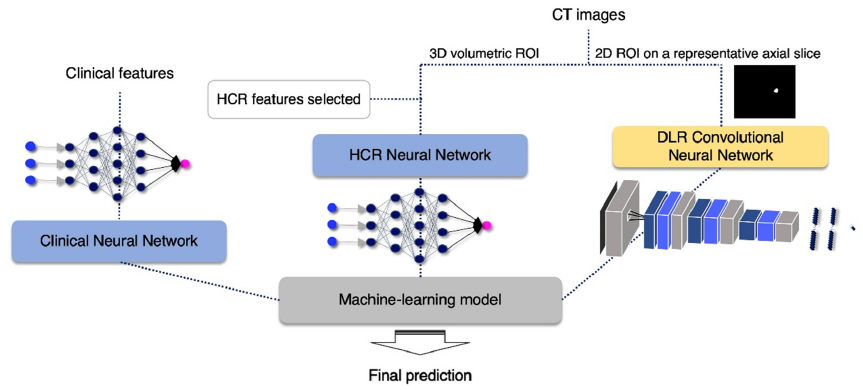
Figure 3. DLR convolutional neural network architecture . In the end, a machine learning-based analyzer was employed to combine the predic- tive outputs (cancer recurrence probability [0, 1]) of each neural network-based model to improve the accuracy of prior models (i.e., ensemble learning). The combined outputs went through a different machine learning-based ensemble analyzer for making the final